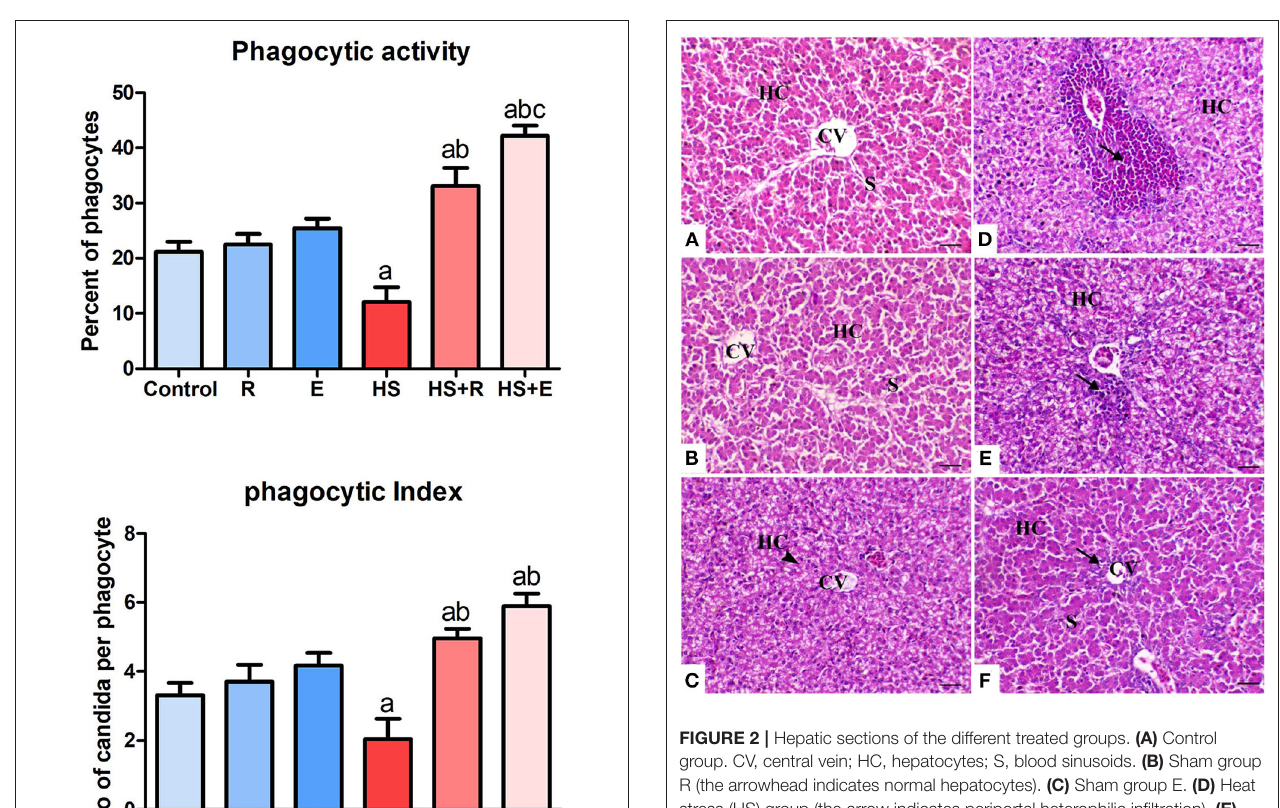
the control group ( P > 0.005). A marked decrease of